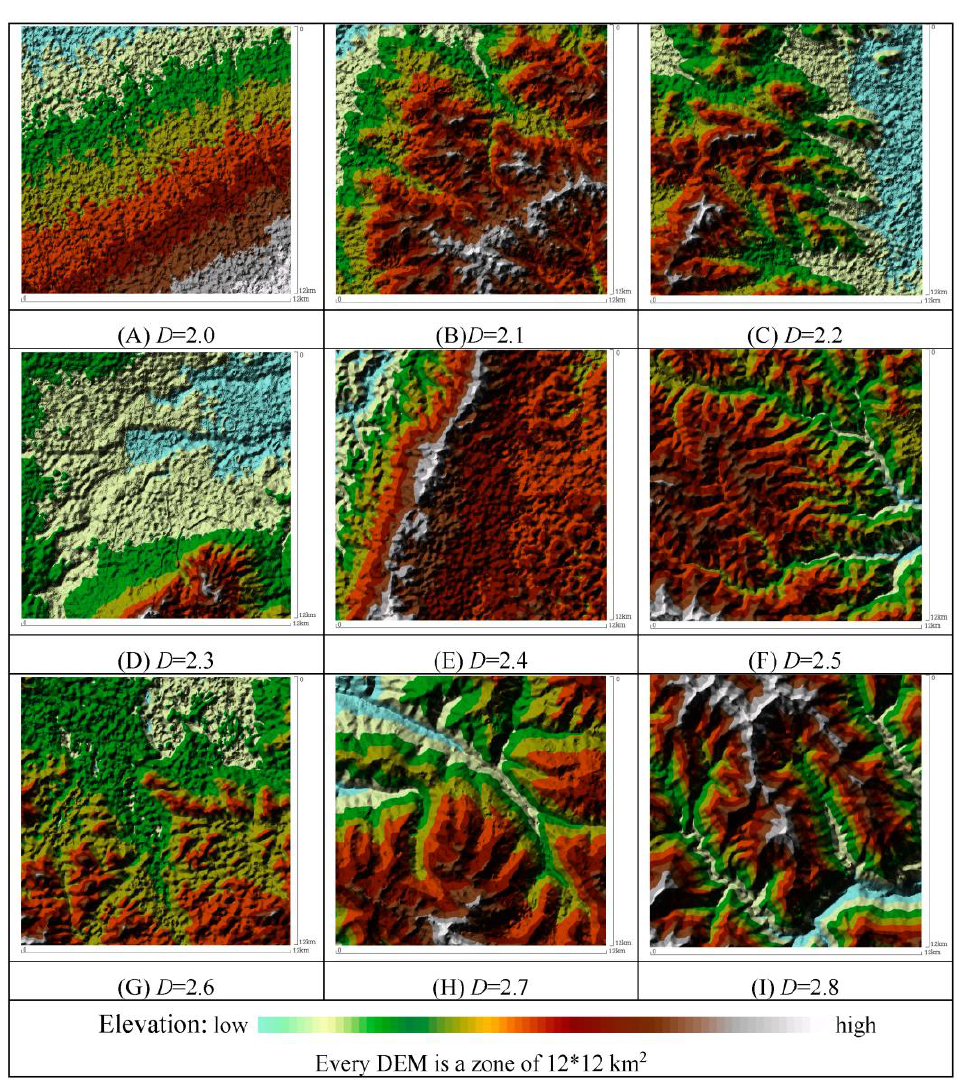
Figure 1. Terrain data with different terrain complexity. ( A ) D = 2.0; ( B ) D = 2.1; ( C ) D = 2.2; ( D ) D = 2.3; ( E ) D = 2.4; ( F ) D = 2.5; ( G ) D = 2.6; ( H ) D = 2.7; ( I ) D =